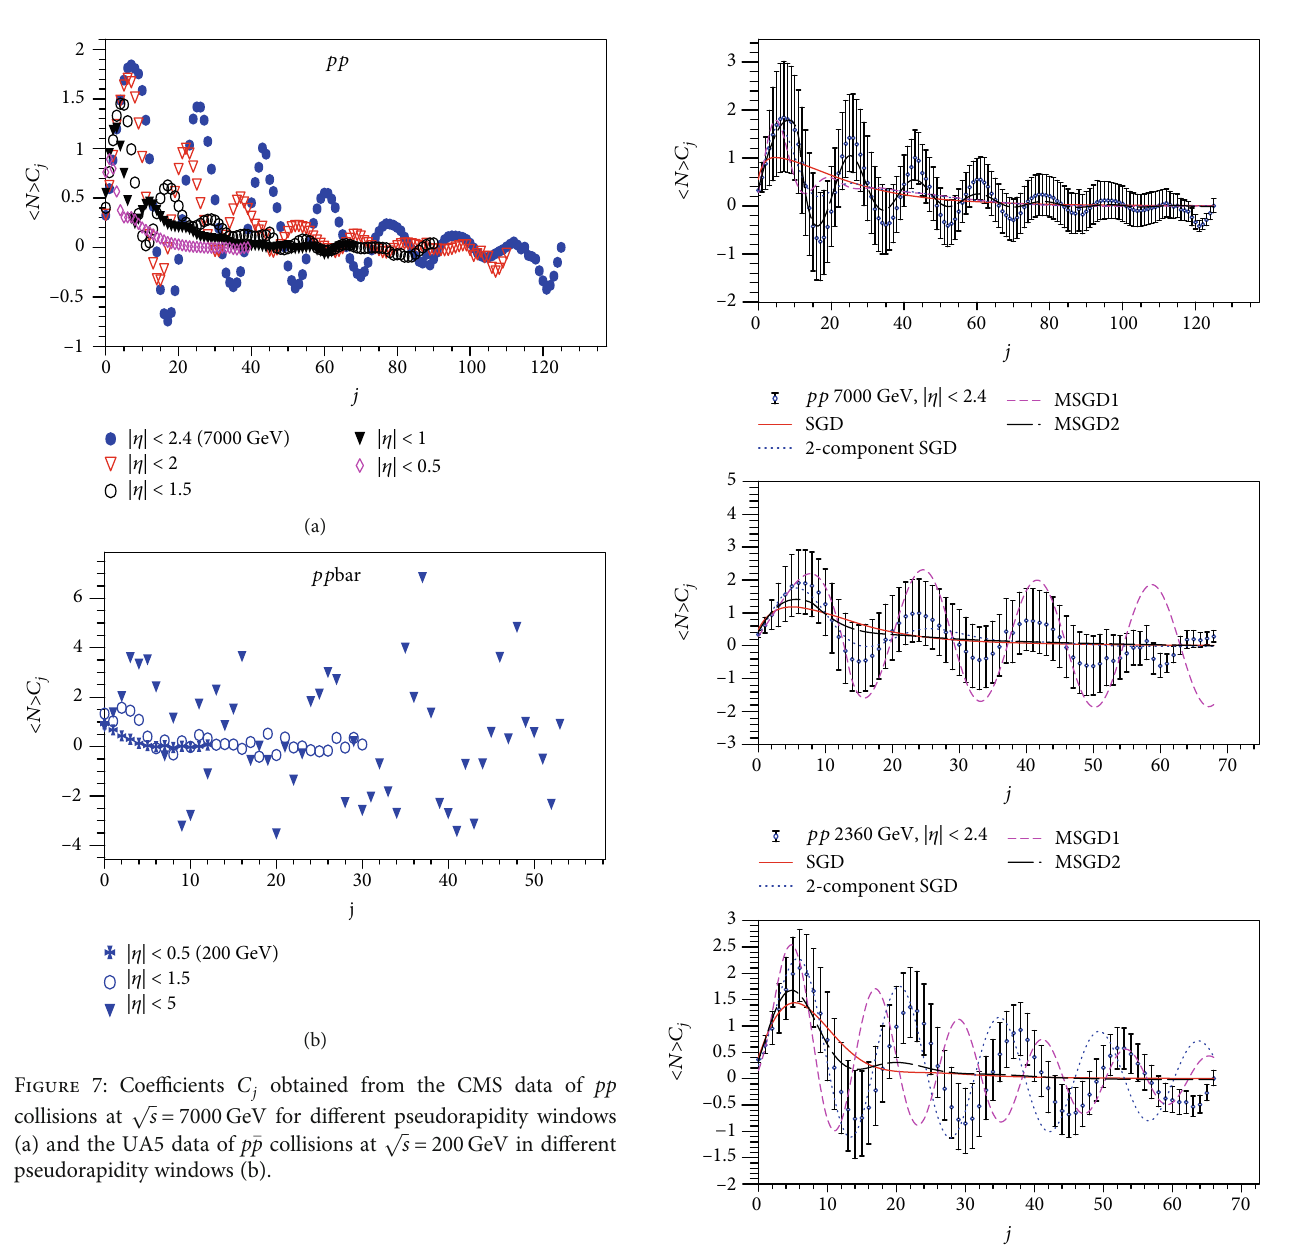
Figure 8: Coe ffi cients C obtained from the CMS data of pp j collisions at di ff erent energies in one pseudorapidity window compared with C obtained from SGD, 2-component SGD, j MSGD1, and MSGD2 distribution fi ts to the data.